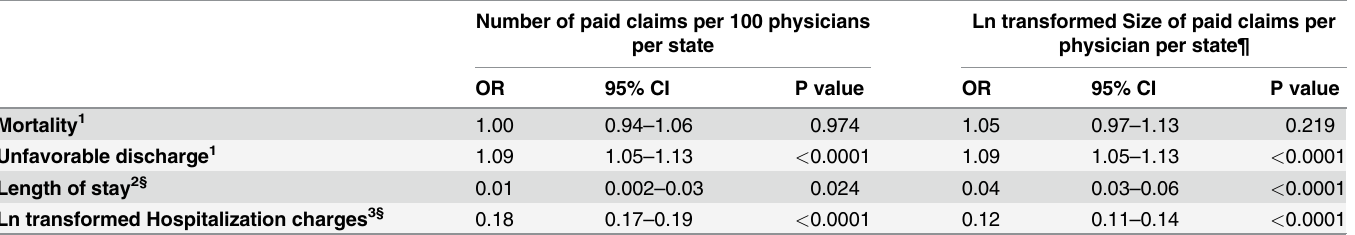
Table 3. Regression models for primary outcomes and variables of